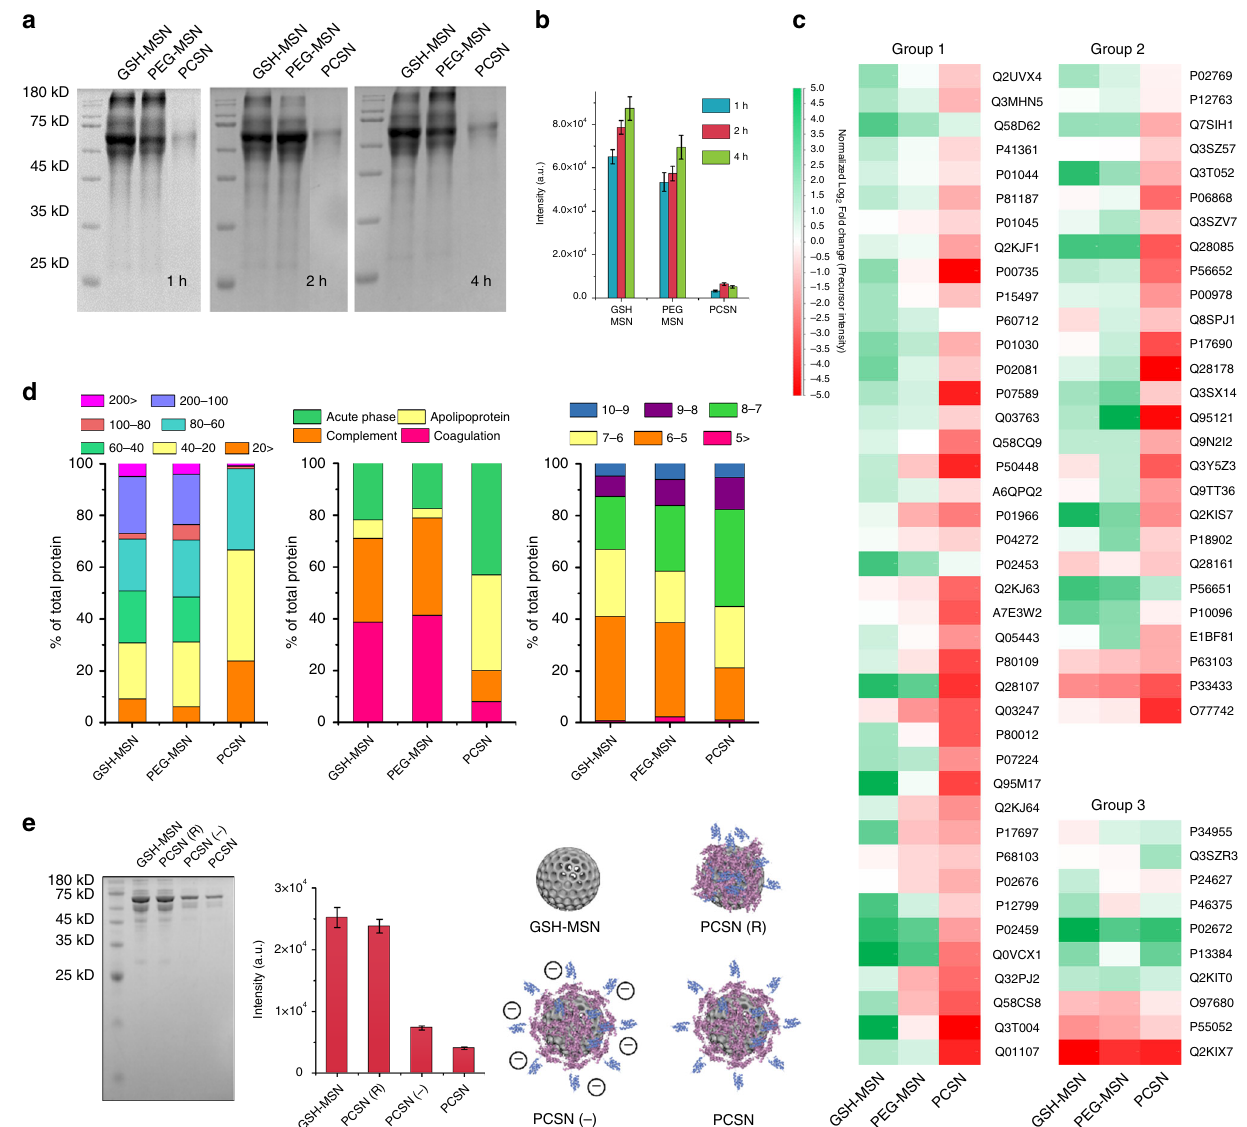
Fig. 2 Proteomic study of surface protein corona. a GSH-MSN, PEG-MSN, and PCSN were treated with 55% serum for 1, 2, and 4 h, and the amount of serum protein attached to the surface was determined by SDS-PAGE. b Band intensity difference. c Classi fi cation of protein corona components characterized by quantitative LC-MS/MS. A total of 183 proteins were identi fi ed and the 78 most abundant proteins were used to make the heat map. d Proteins attached to each particle were classi fi ed by weight (kDa), category, and pI. e GSH-MSN, PCSN(R), PCSN( − ), and PCSN were treated with 55% serum for 1 h and the amount of serum protein attached to the surface was determined by SDS-PAGE. All bar graphs were reported as means ± standard deviations (SDs) for three experimental replicates ( n =